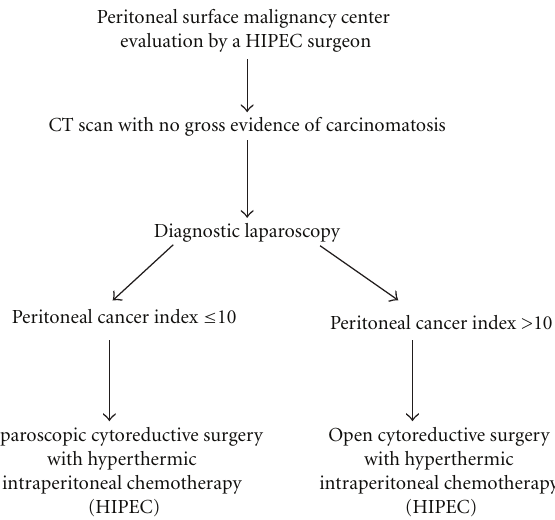
Figure 1: Clinical pathway for the laparoscopic management of peritoneal surface malignancies.